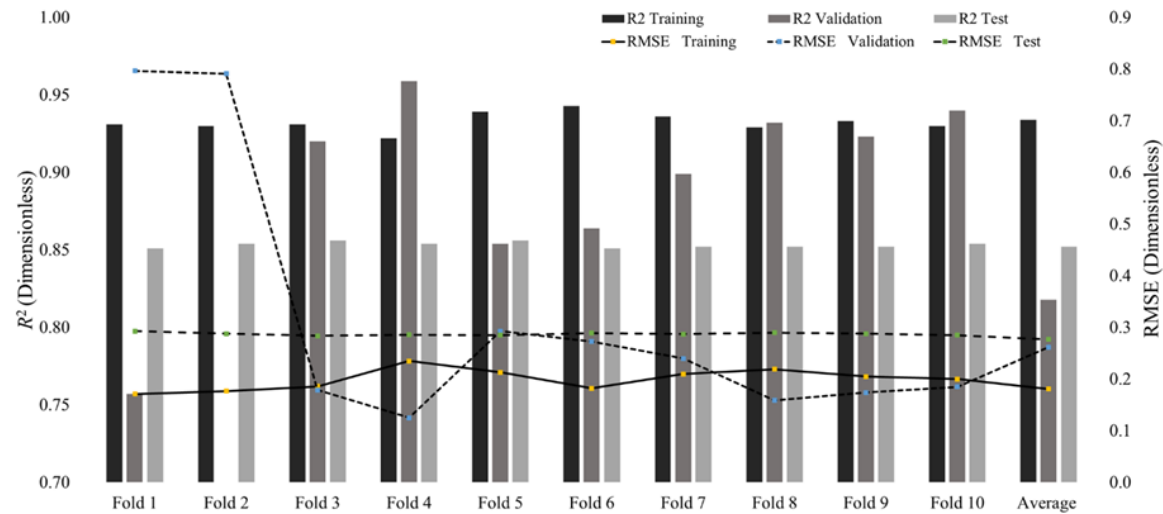
Figure 11. Performance of the 10-fold cross-validation obtained using the LSTM model.